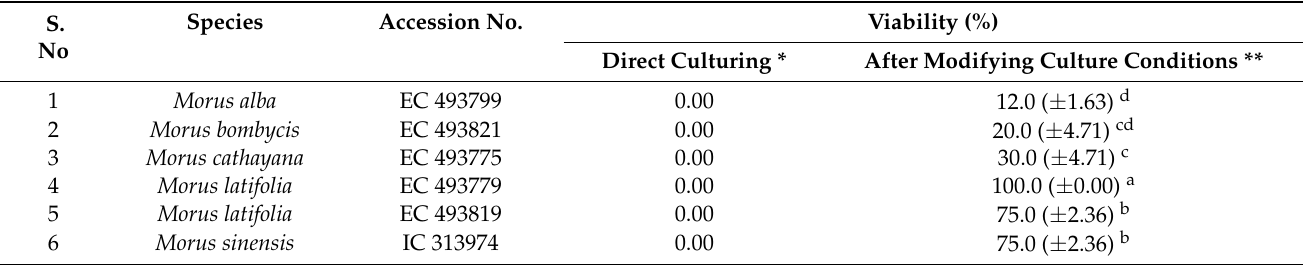
Table 4. Improved viability of cryostored Morus species after rehydration and culturing in the dark.